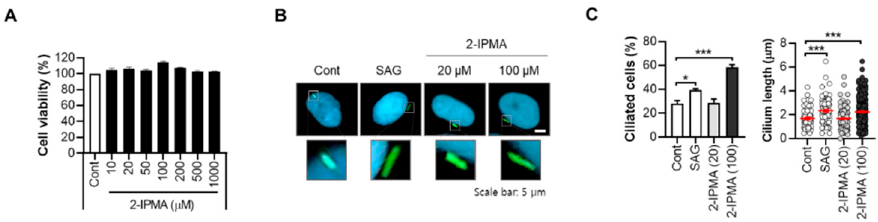
Figure 1. 2-IPMA promotes primary ciliogenesis in normal dermal fibroblasts. ( A ) Normal dermal fibroblasts were treated with different concentration of 2-IPMA (10–1000 μ M) and cell viability was determined by CCK-8 assay. ( B , C ) Normal skin fibroblasts were treated with either SAG (1 µ M) or 2-IPMA (20, 100 µ M). ( B ) Then, the cells were imaged by immuno-staining with ARL13B antibody (green) and Hoechst dye (blue). Scale bar: 5 µ m. ( C ) The ciliated cells and cilium length of the cells were measured under a fluorescence microscope. Data are presented as the mean ± SEM ( n = 100, * p < 0.05, *** p < 0.005).